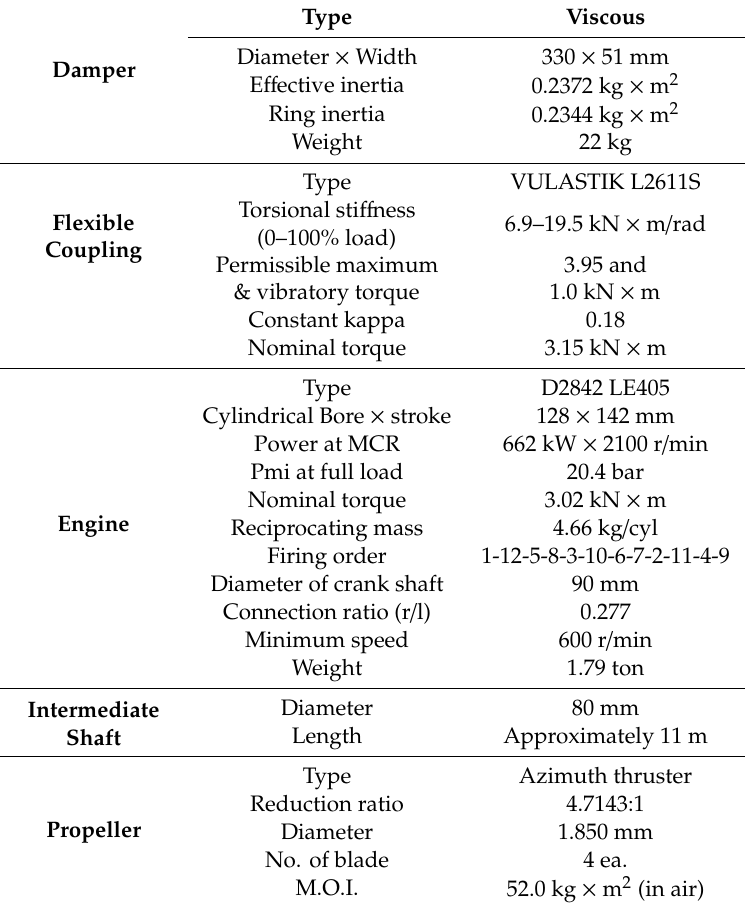
Table A1. System Specifications for 150-ton Class Oil-skimmer Ship (by courtesy of